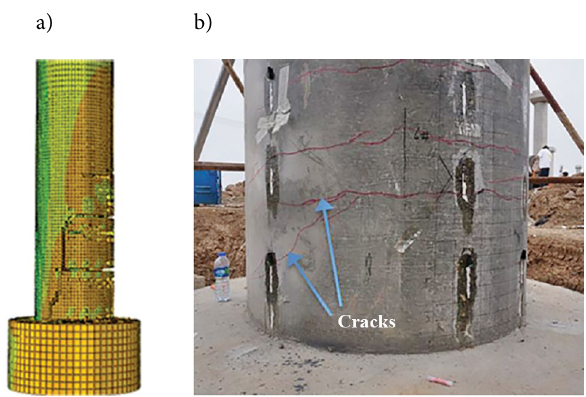
Figure 13. Cracks after column fails: a – FE results;